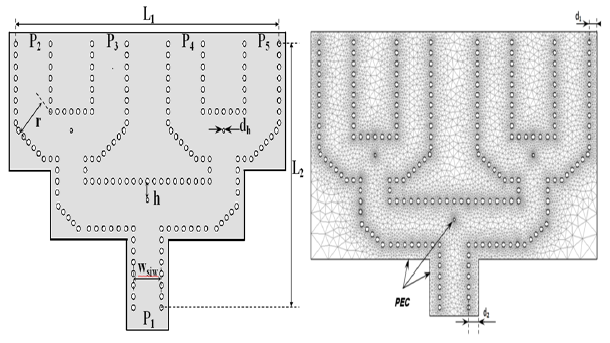
FIGURE 4. The Four-way SIW power divider structure with chamfered bend and center via (L1 = 62.4 mm, L2 = 38.69 mm), (a) H-plane top view, (b) Mesh according to the Delaunay procedure.